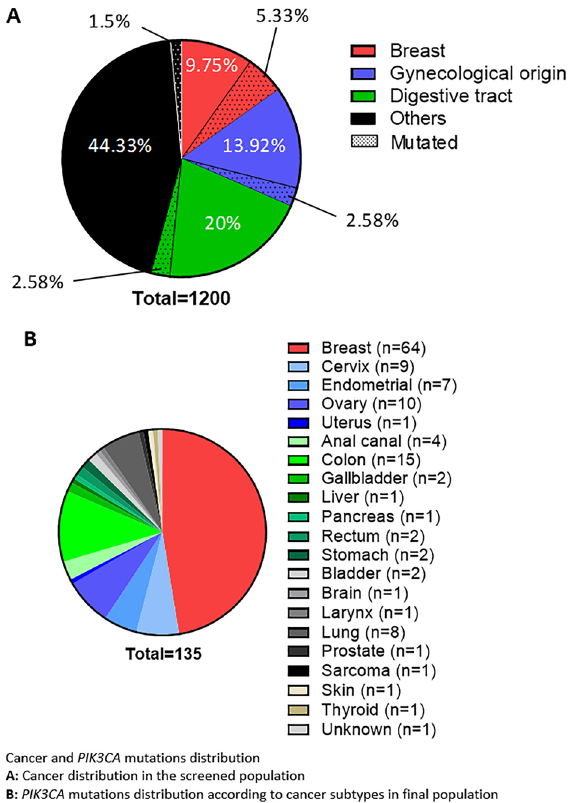
Figure 1. Cancer and PIK3CA mutations distribution( A ) Cancer distribution in the screened population.( B ) PIK3CA mutations distribution according to cancer subtypes in final